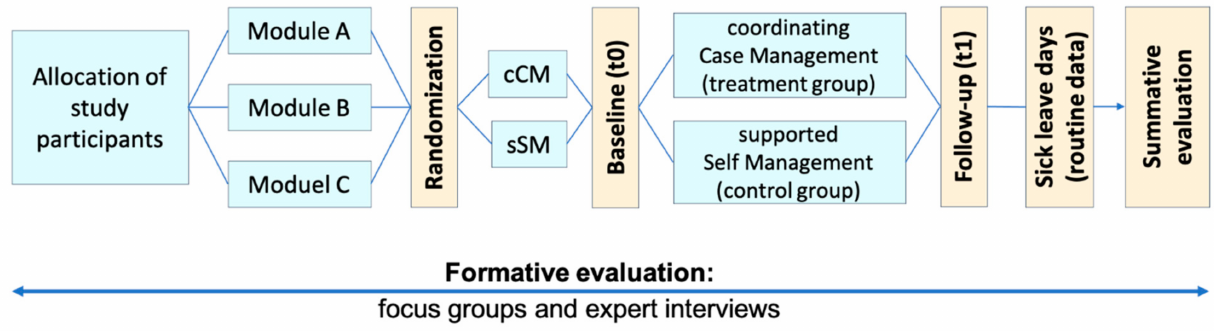
Figure 1. Evaluation design (cCM = coordinating case Management, sSM = supported